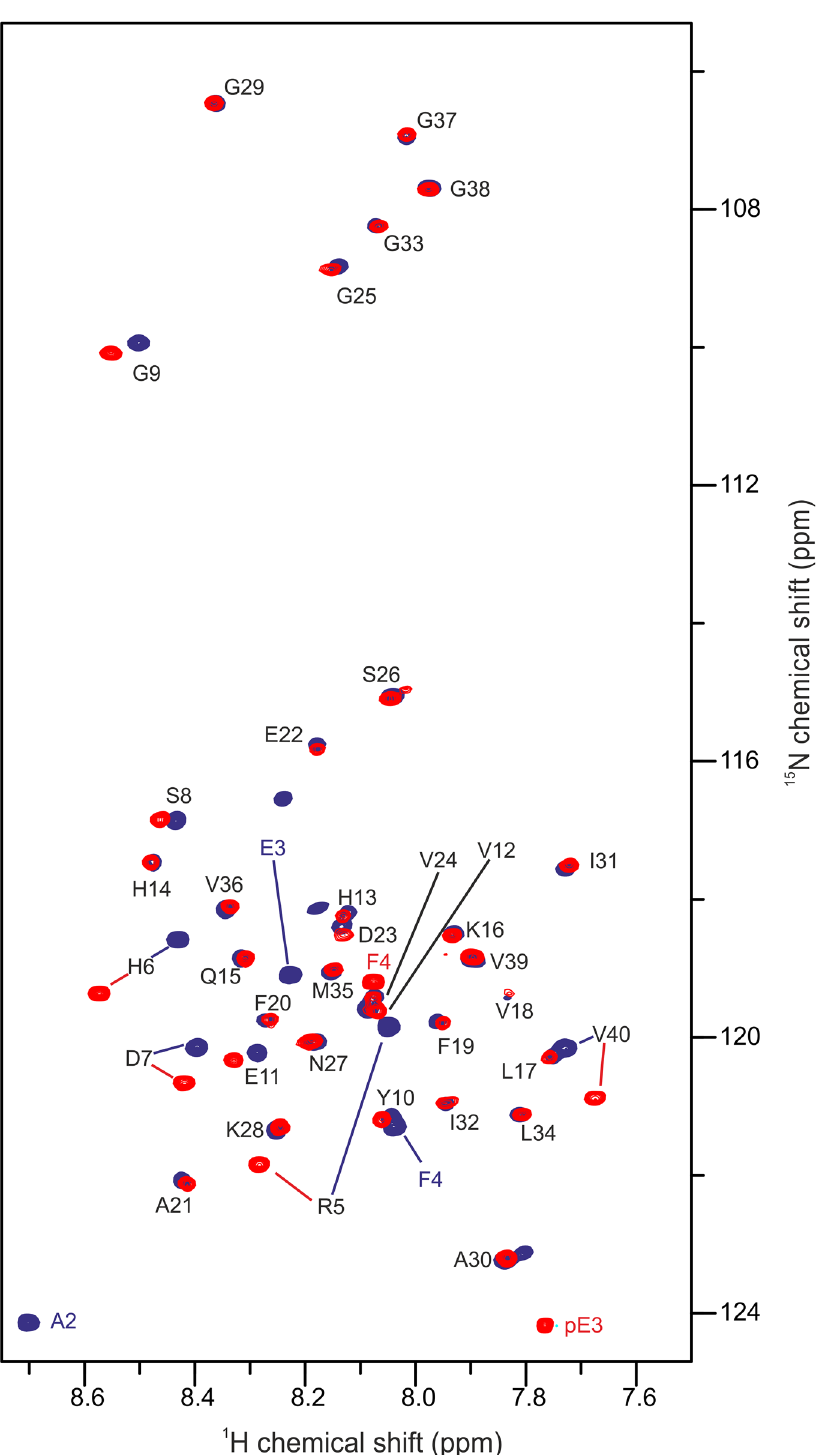
Fig 4. 1 H, 15 N-HSQC of pEA β (3 – 40) and A β (1 – 40). 25 μ M of the monomerized peptides were dissolved in aqueous solution (50 mM potassium phosphate, pH 2.8) containing 20% TFE. Spectra were recorded on a 600 MHz Bruker spectrometer at 5°C. Overlay of the spectrum of pEA β (3 – 40) (red) and A β (1 – 40) (blue) indicate that the pyroglutamate modification affects the N-terminal signals significantly towards E11 as well as